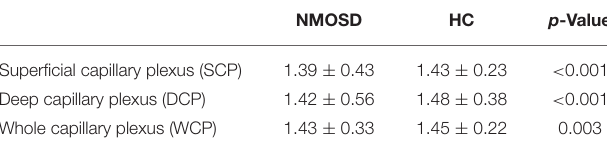
p-Values were adjusted for age, gender, the signal value of angiogram, and intereye